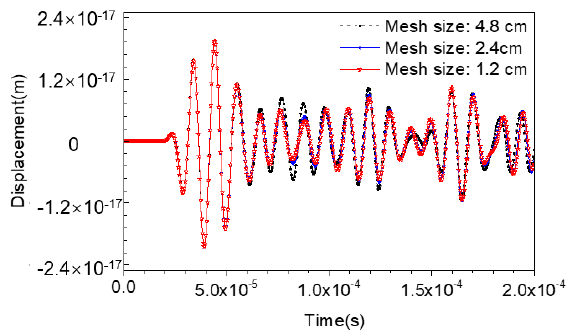
Figure 5. Mesh sensitivity analysis.